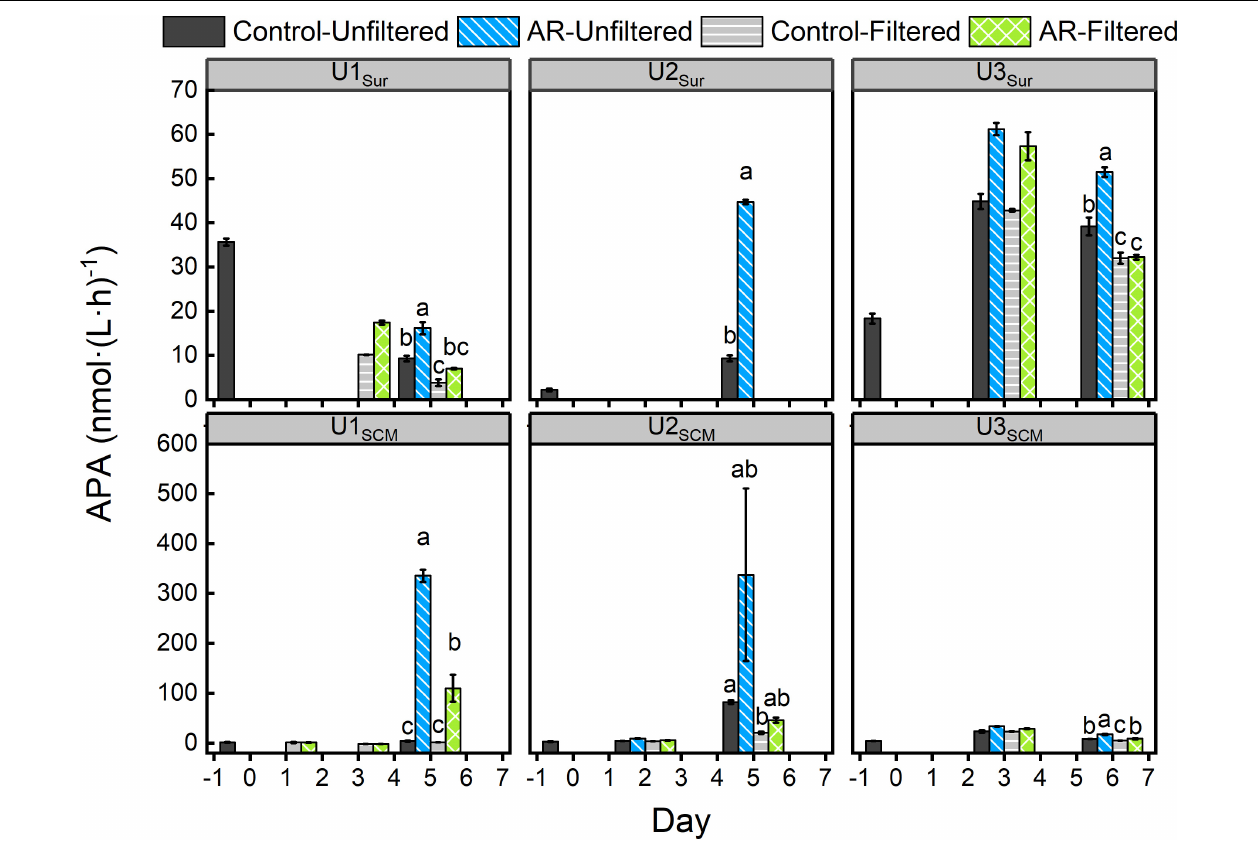
FIGURE 3 | Changes in alkaline phosphatase activity (APA) in the control and AR treatments incubated with surface and SCM seawaters. Treatment in the last day was compared by Ducon’s range test, and the treatment with same letter was not significantly different ( α = 0.05). The error bar represents the standard deviation of three parallel